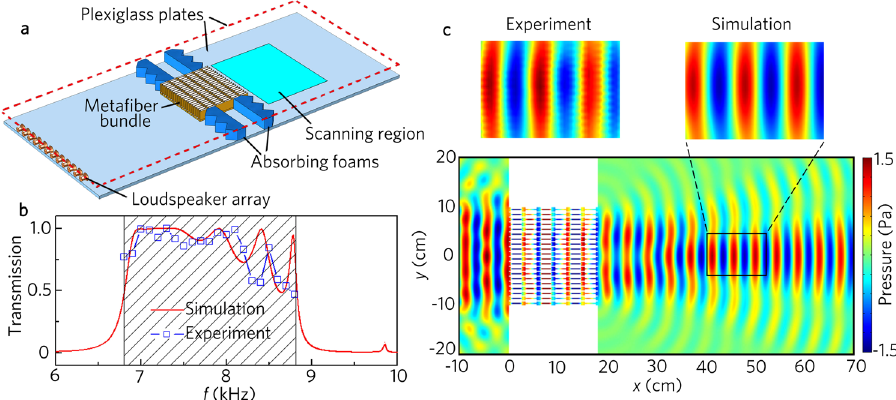
Figure 2. Transmission performance. ( a ) Schematic of the experimental set-up. The top plate of the waveguide (not shown in the diagram) is located 10 mm above the bottom plate. ( b ) Simulated and measured transmission spectra with the acoustic metafiber bundle shown in 1a . ( c ) Simulated and measured acoustic pressure field distributions with the acoustic metafiber bundle illuminated by the normally incident plane wave at 8.0 kHz.